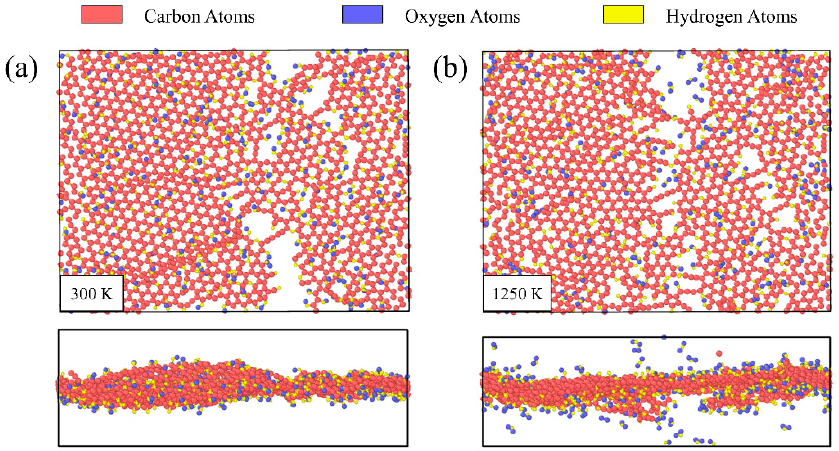
Figure 12. Vacancies in the PGO structure at high temperature. ( a ) PGO tensile process under 300 K; ( b ) PGO tensile process under 1250 K.